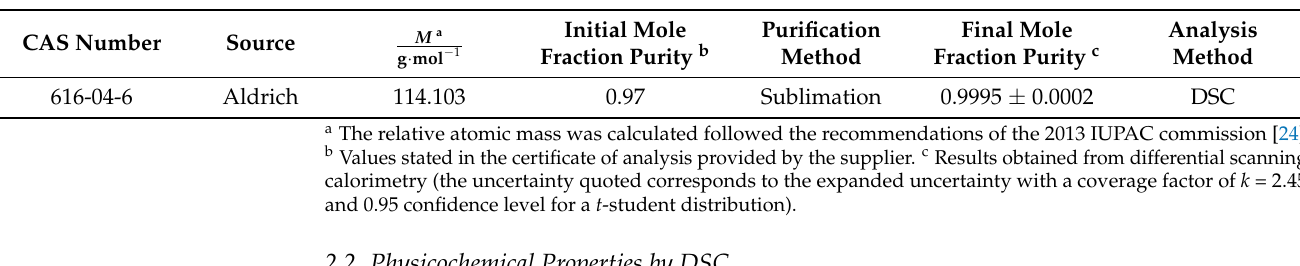
Table 1. Chemical data, source, and purities of the 1-methylhydantoin utilized in this work.